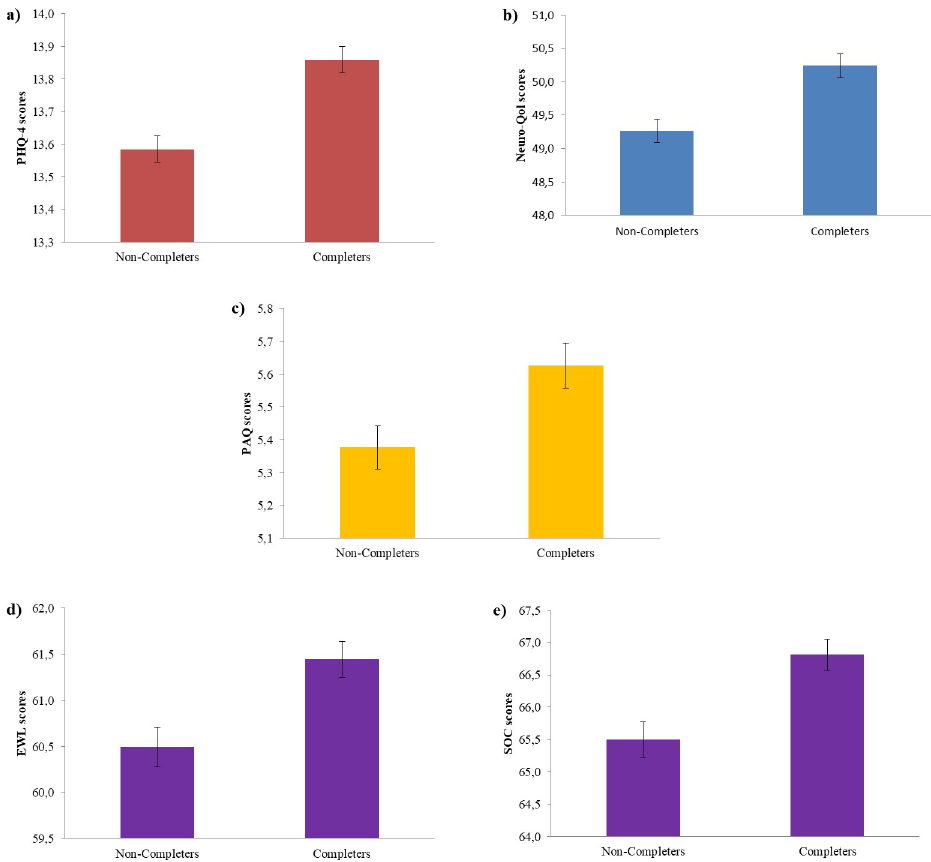
Fig 5. Comparison of baseline lifestyles scores (y axis) of participants who did and did not complete the follow-up (x axis) in a) Emotional health, b) Cognitive health, d) Physical activity, e) Engagement with life, and e) Sense of